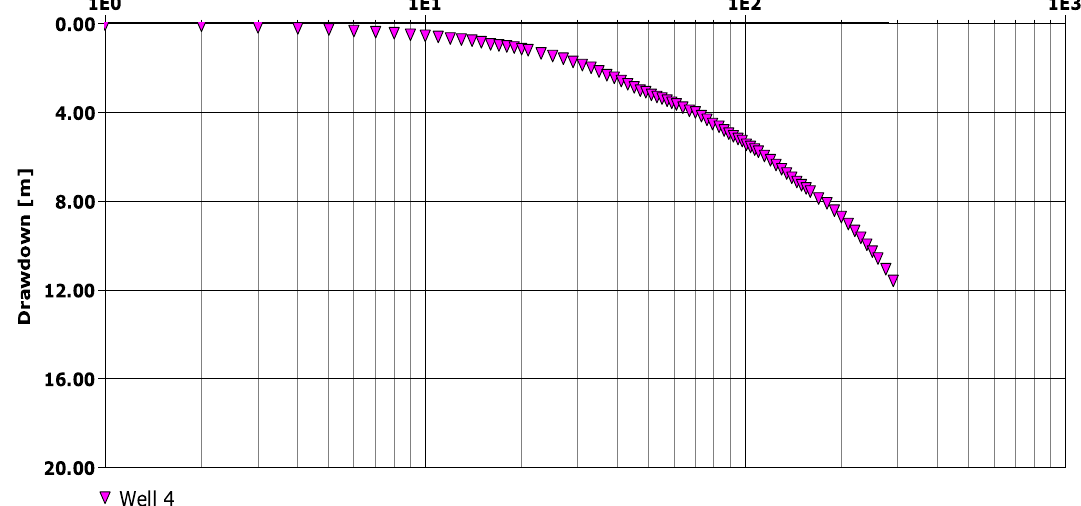
Fig. 21 Theis’s method of pumping well-4